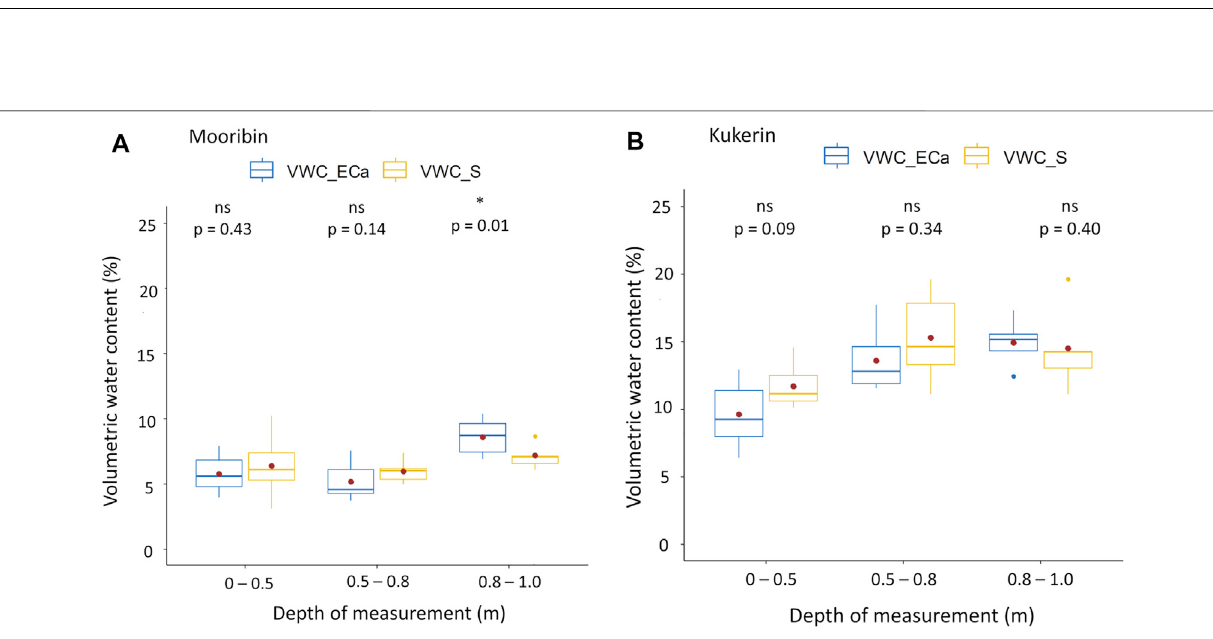
Frontiers in Environmental Science |